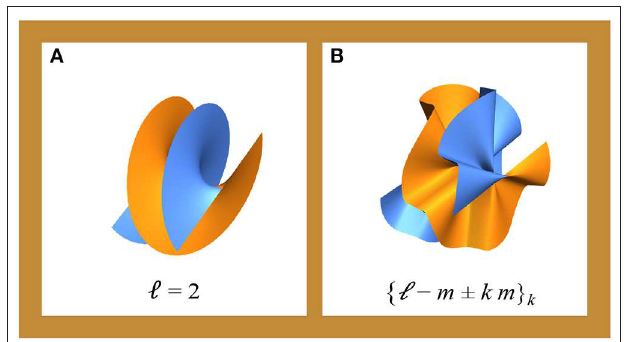
FIGURE 2 | Helical wavefronts corresponding to a circumference (A) and to the curve represented in Figure 1A(B) .